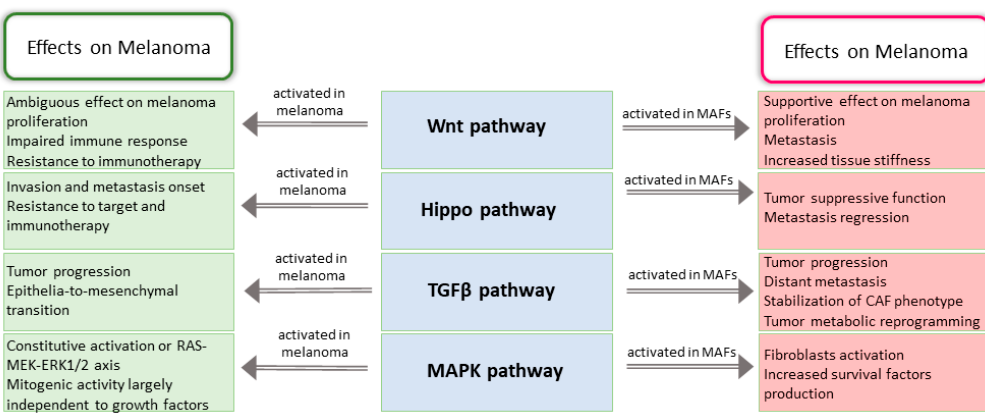
Figure 2. Tumor promoting function of oncogenic pathways deregulated in CAFs. Scheme recapitulates data presented concerning Wnt, Hippo, TGF β and MAPK pathways deregulation in MAFs and melanoma cells. Mostly, activation of these pathways in MAFs exerts a pro-tumorigenic effect with the exception of Hippo signaling that trigger a competition between tumor and stroma characterized by a tumor-suppressive function.